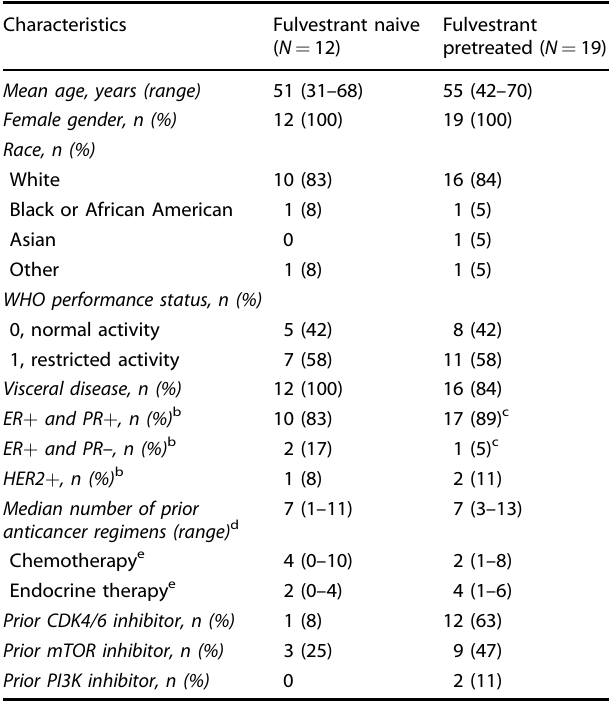
Table 1. Demographic and disease characteristics in 31 PTEN -mutant a ER + MBC patients treated with capivasertib and